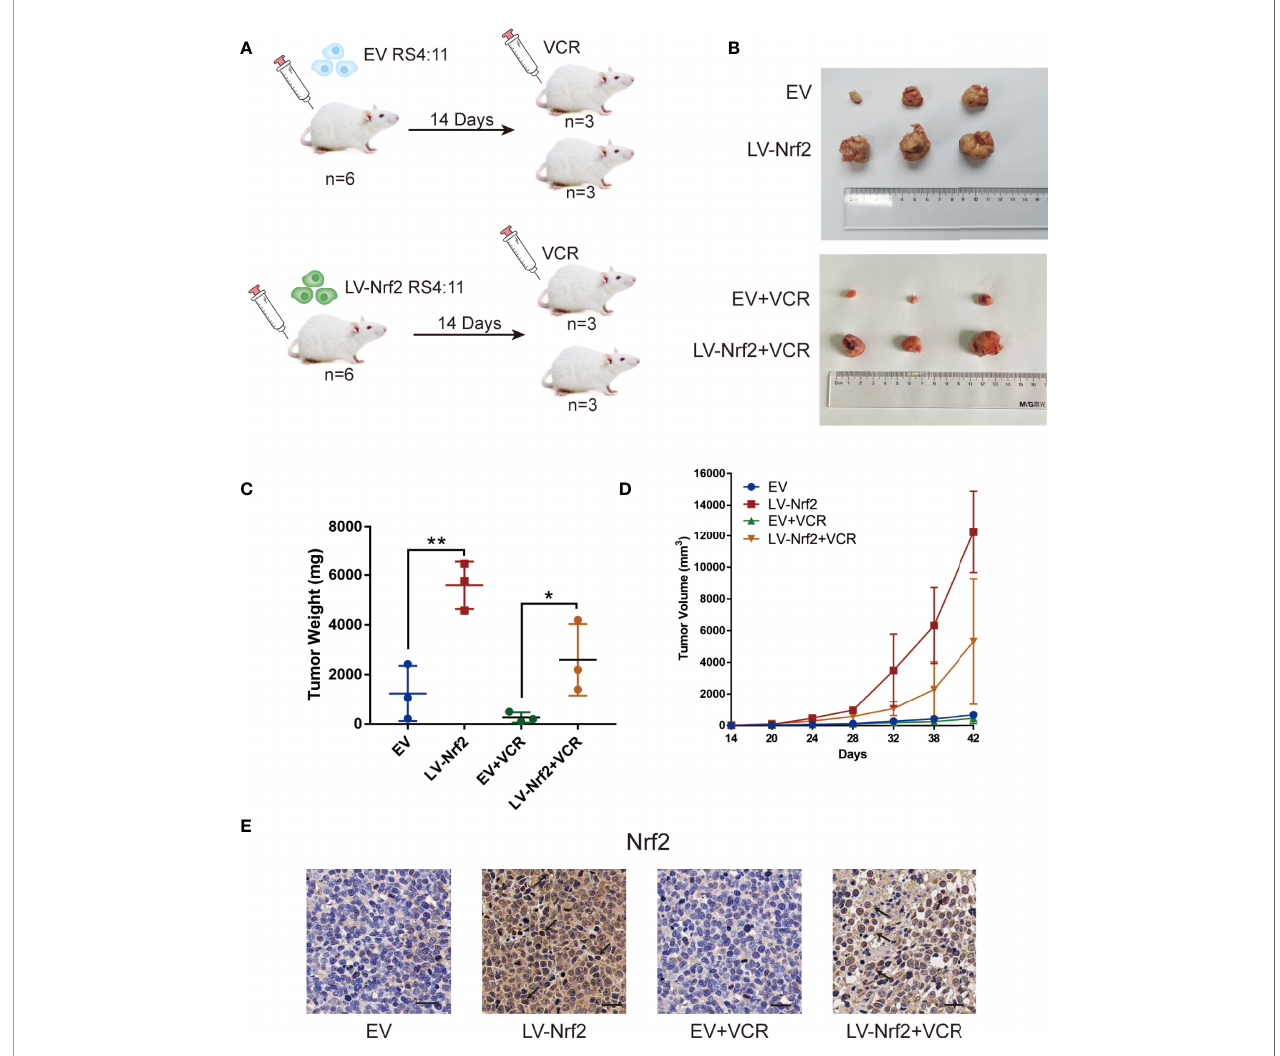
FIGURE 5 | (A) Model of mouse subcutaneous tumor formation. (B) Images of subcutaneous xenografts from mice in the EV group (n = 3), LV-Nrf2 group (n = 3), EV +VCR group (n = 3) (VCR, 80 mg/kg/day for 6 days), LV-Nrf2+VCR group (n = 3) (VCR, 80 mg/kg/day for 6 days). (C) Tumor weight change curves for subcutaneous xenografts. *P < 0.05, **P < 0.01. (D) Tumor volume growth curves for subcutaneous xenografts. (E) The expression of Nrf2 was examined in xenograft tumor tissue sections using immunohistochemistry (IHC) (scale bars: 50 m